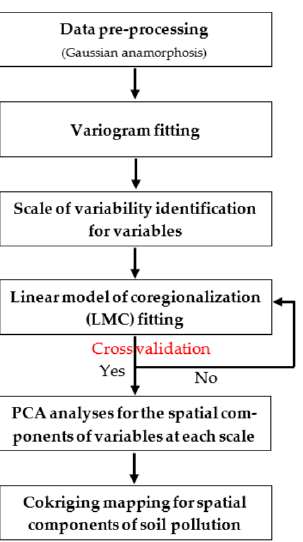
Figure 2. A flowchart of the multivariate factorial kriging analysis.